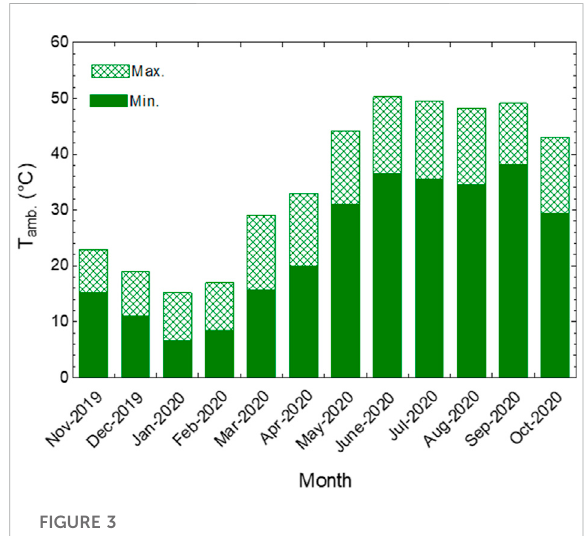
FIGURE 3 Variation of the ambient temperature with time.